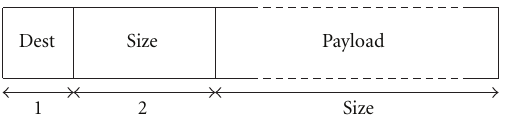
Figure 6: Header and the payload of the stored data in the serialization